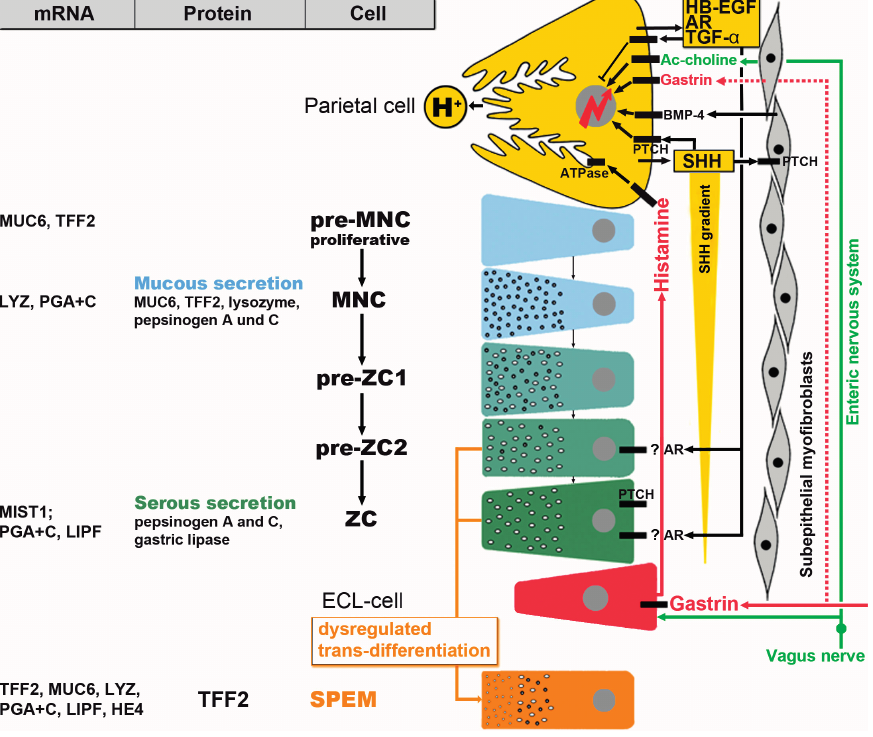
Figure 2. Schematic representation of the trans-differentiation of mucous neck cells (MNC, blue) towards zymogenic cells (ZC, green) under the control of parietal cells (yellow); the dysregulated trans-differentiation results in formation of the “spasmolytic polypeptide-expressing metaplasia” (SPEM; orange), which characteristically secretes TFF2. Immature progenitors for MNCs (pre-MNC) in the proliferative region of fundic units mature stepwise (pre-ZC1, pre-ZC2) towards ZCs, which is accompanied by a re-organization of the secretory apparatus (mucous to serous). Shown, also, is the distribution of characteristic transcripts and proteins, which is not congruent in these cells. AR, amphiregulin; BMP, bone morphogenetic protein, HB-EGF, heparin-binding EGF-like growth factor; PTCH, Patched; TGF- α , transforming growth factor α ; (modified and updated from